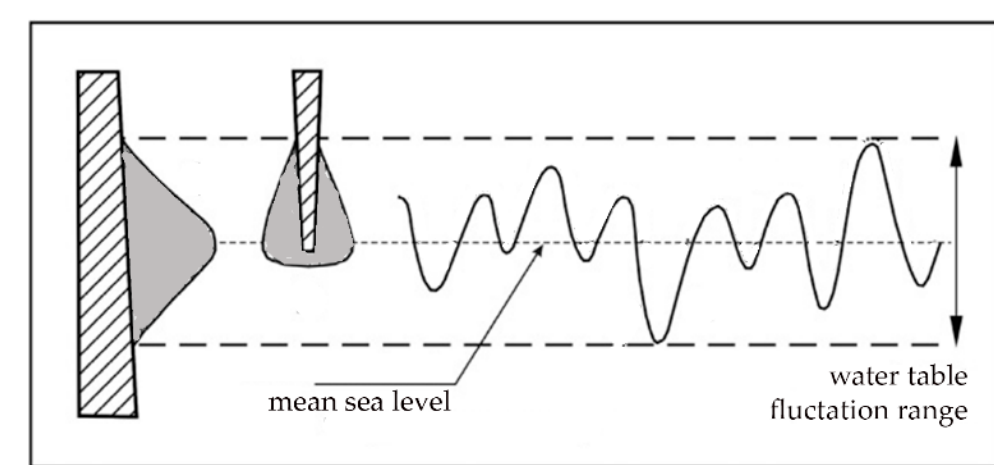
Figure A1. Tide amplitude and POS accretion, redrawn from [29].